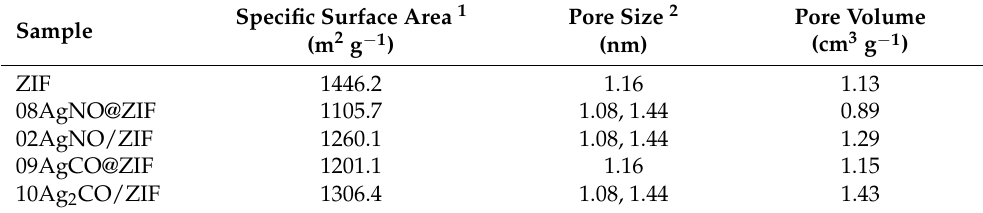
Figure 2. ( a ) N 2 adsorption/desorption isotherm, and pore size distribution ( b − 1 ) ZIF (as-synthesized ZIF-8), ( b − 2 ) 08AgNO@ZIF (de novo), ( b − 3 ) 02AgNO/ZIF (impregnation) samples. Table 2. Specific surface area and pore size distributions of synthesized